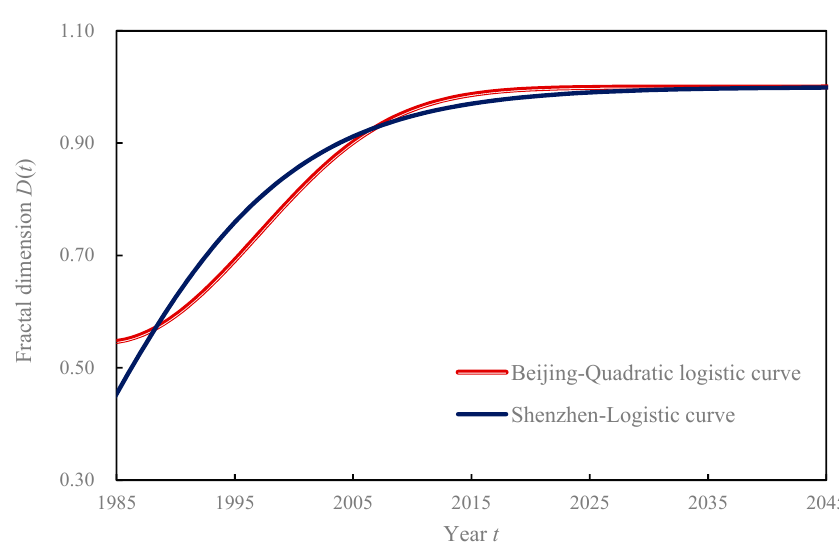
Figure 6. Two types of fractal dimension increase curves of urban form: logistic curve and quadratic logistic curve. Note: The logistic curve is based on the time series of Shenzhen’s box dimension values, while the quadratic logistic curve is based on the time series of Beijing’s box dimension values. The fractal dimension values of Beijing come from Chen and Huang [6]. For comparability, the fractal dimension values are normalized by maximum and minimum fractal dimension values [54].